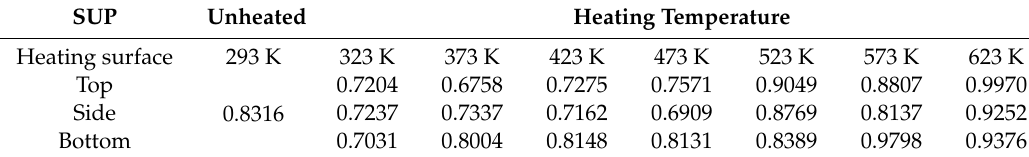
Table 5. Uniformity of the three heating positions at the di ff erent heating temperatures.